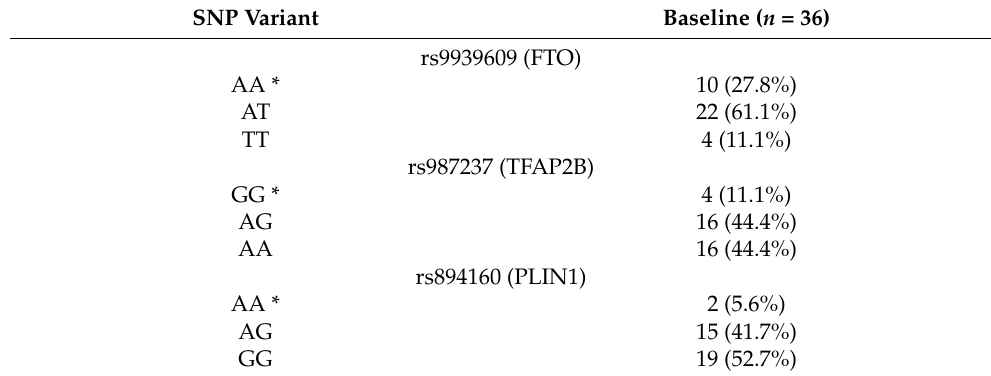
Table 4. SNP distribution in the study